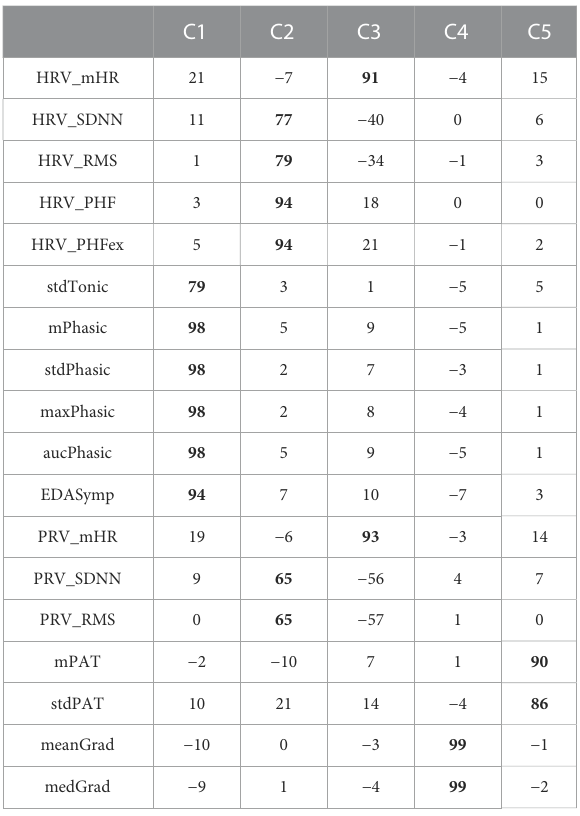
TABLE 10 Scoring coef fi cients for computing component scores.